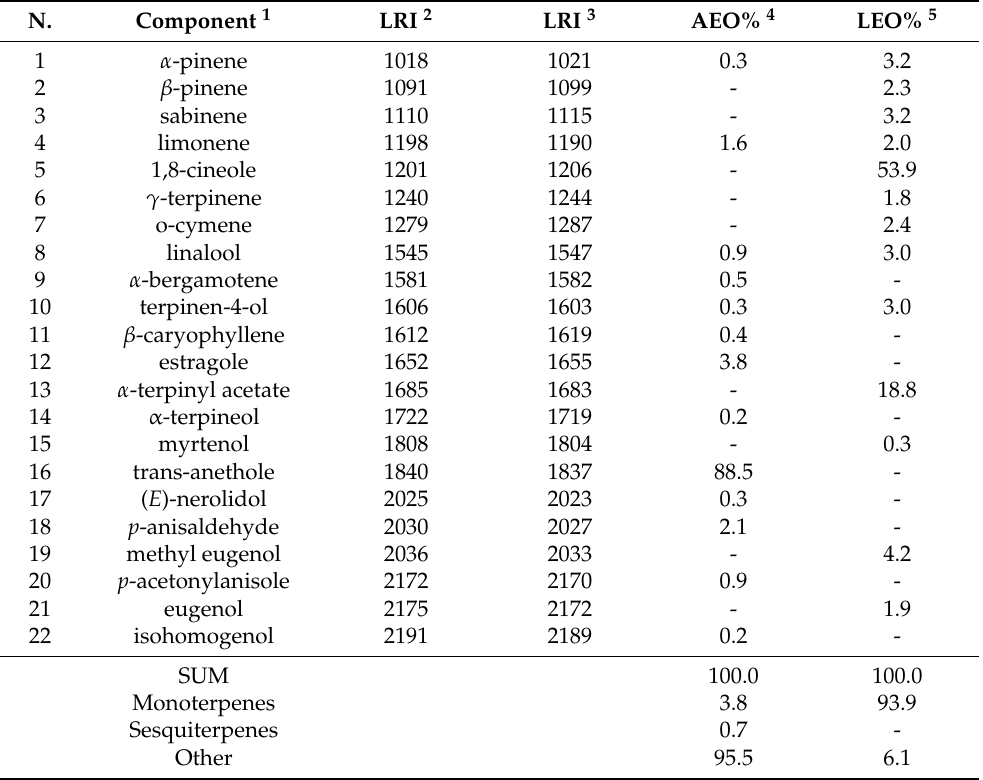
Table 1. AEO and LEO chemical